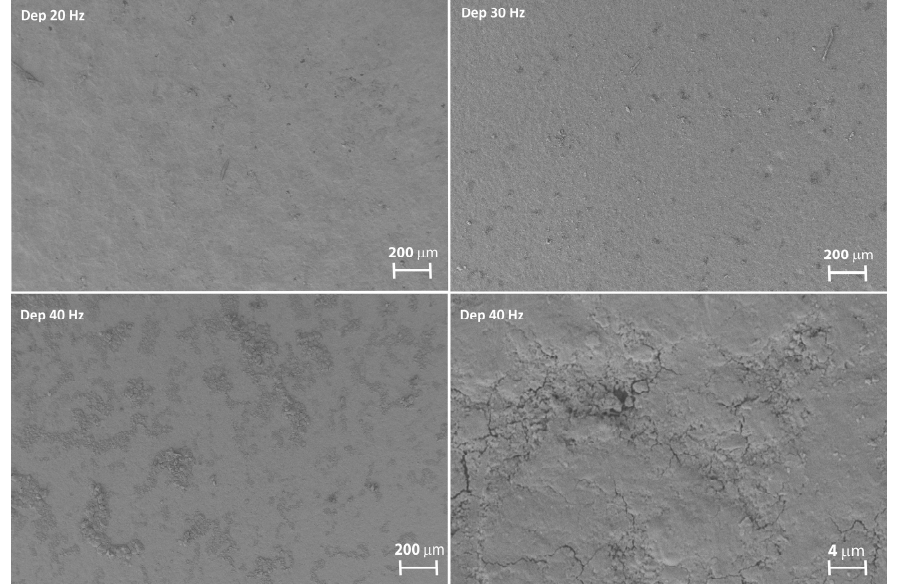
Figure 10. SEM images of the superficial coating layer.